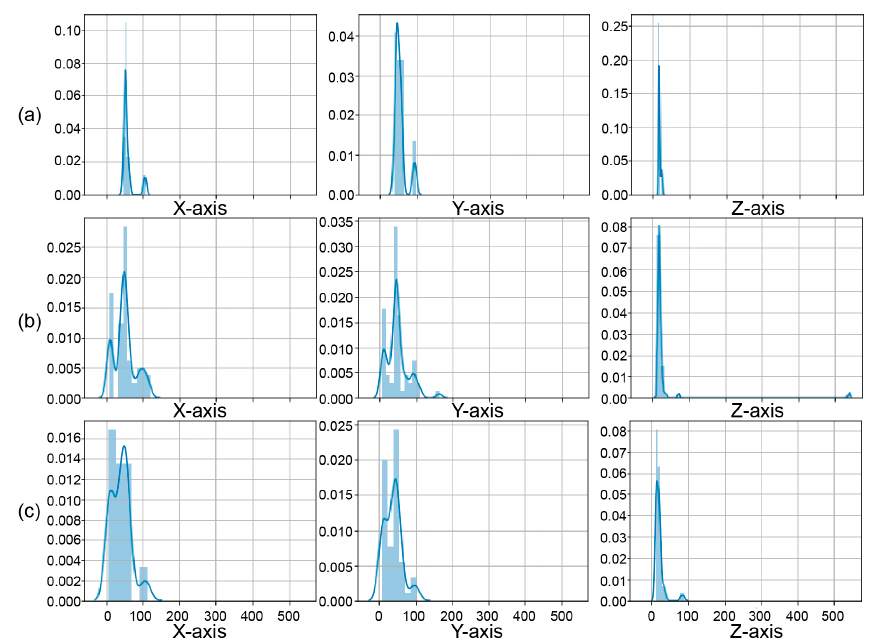
Figure 4. Histogram of mean spectral intensity of three lithological samples. ( a ) Fine Gravel Sandstone, ( b ) Fine Sandstone, ( c ) Mudstone.